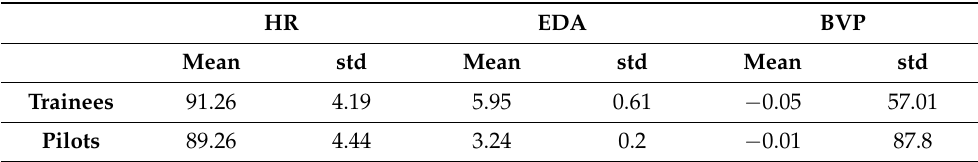
Table 3. Mean of features (mu and std) means by experimental groups of trainees and pilots when in an inactive state (before the first navigation event